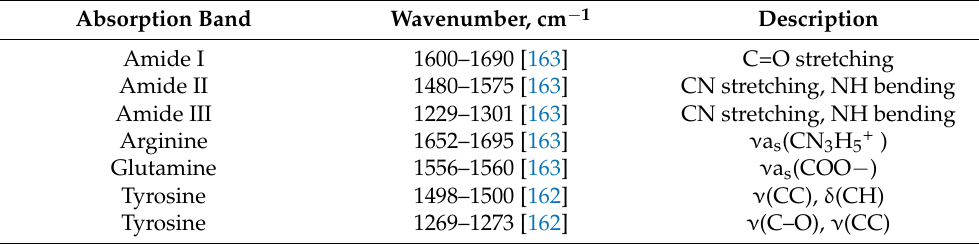
Table 3. Vibrational absorption bands of proteins in the MIR region. Absorption